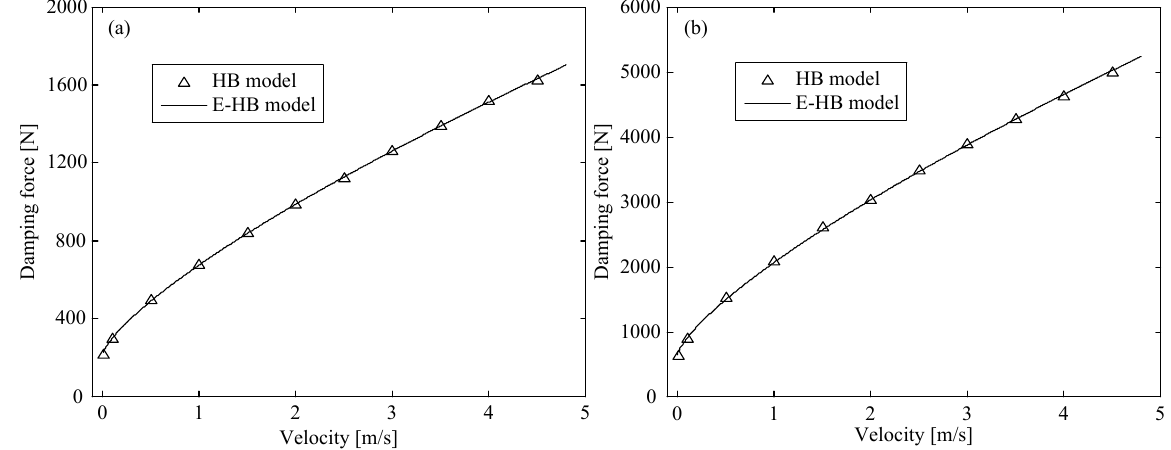
Figure 7. Damping force vs. velocity curve in ( a ) axial and ( b ) annular channels.